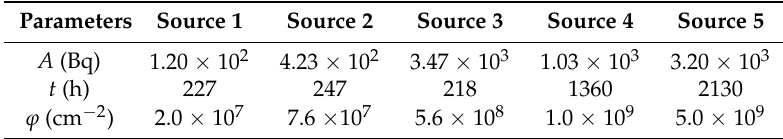
Table 1. The values of irradiation time ( t ), fluence ( ϕ ), and total activity ( A